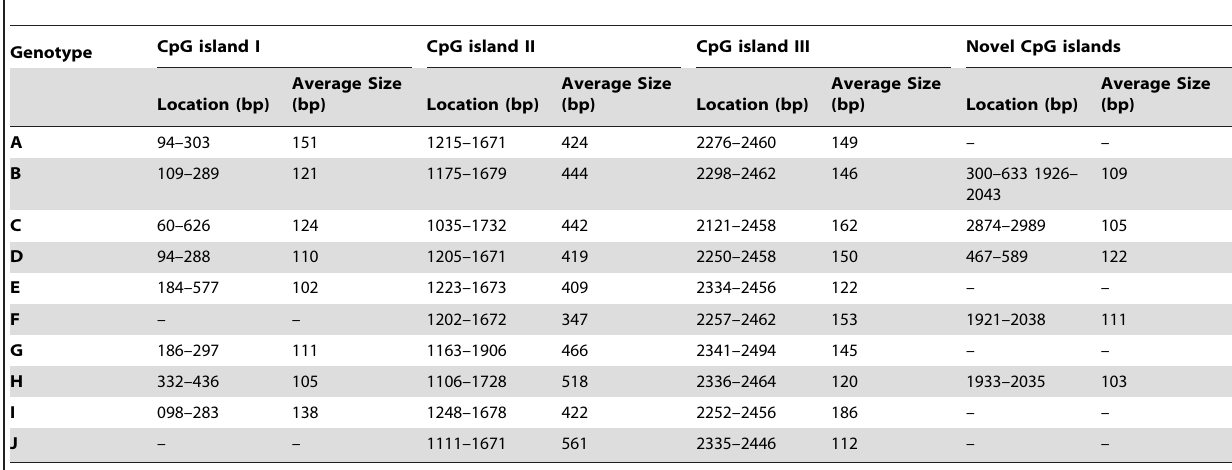
Table 2. The location and size of the three conventional and novel CpG islands within HBV sequences of different genotypes.